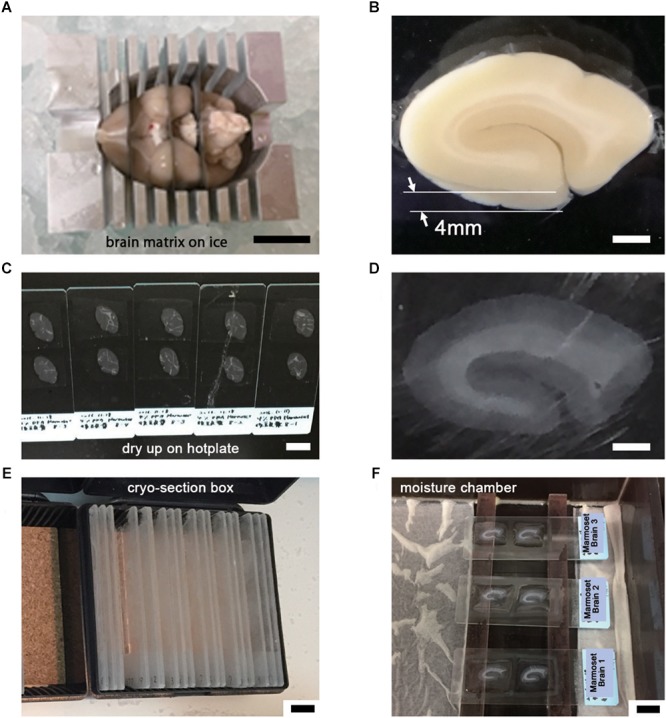
Tissue preparation for LA-CLEM observation. (A) After perfusion with 4% PFA pH 7.4 in PBS, brain tissue was dissected into coronal blocks 3–6 mm in thickness suitable for cryomolds (Tissue-Tek) with the brain matrix on ice. (B) The target brain area was dissected under an optical microscope using a blade. In this experiment, a whole coronal block from the occipital lobe of marmoset brain was prepared at 4 mm thickness. (C–E) Frozen sections at 20 μm thickness were prepared using a cryostat; completely dried sections on slides were stored in a cryosection box and preserved in a freezer at –30 or –80°C. (F) The sections were thawed and redried, followed by the application of blocking solution on the day of antibody staining. Scale bars: (A) 1 cm, (B) 2 mm, (C) 1 cm, (D) 2 mm, (E) – (F) 1 cm.